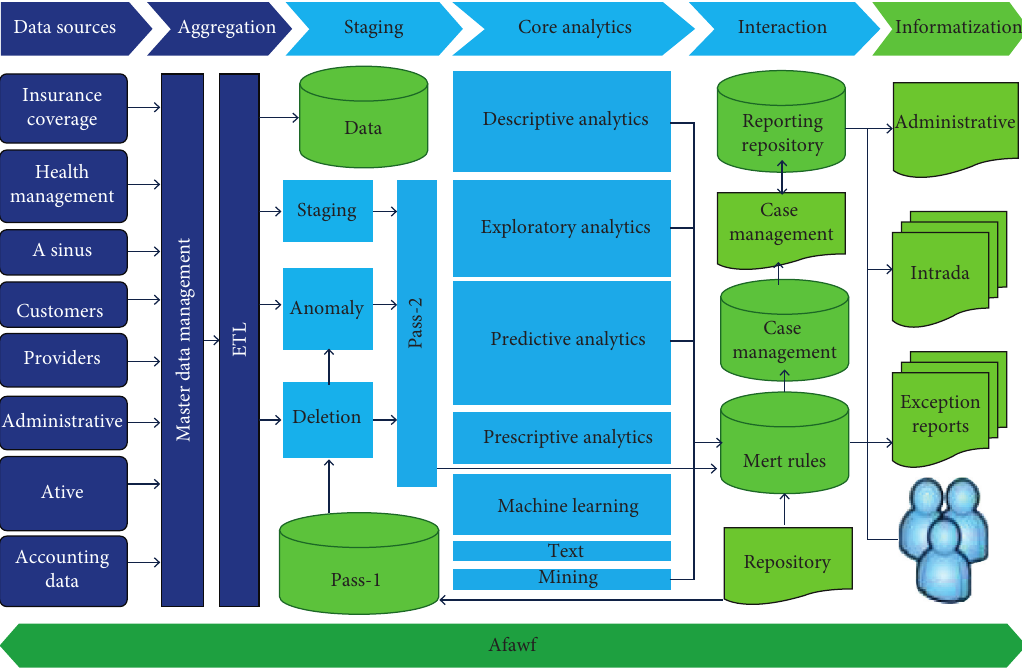
Figure 1: Crowd counting process